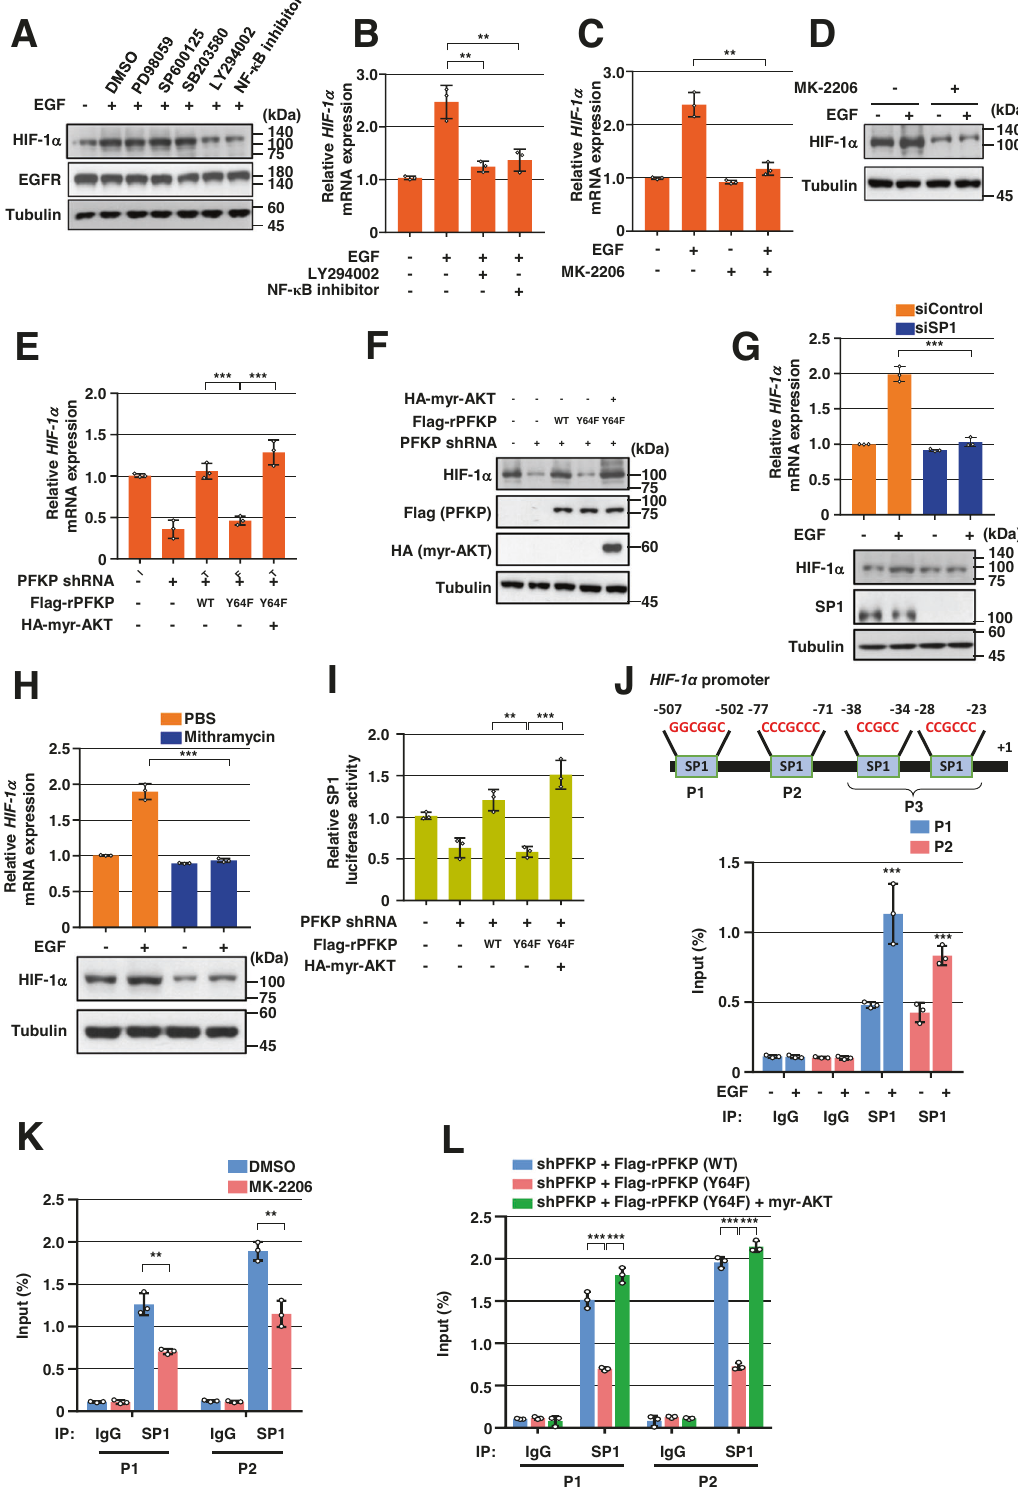
expressing its WT counterpart, however, this reduction was abrogated by expressing an active AKT1 mutant (Fig. 2I). Next, we performed a chromatin immune precipitation (ChIP) assay with an anti-SP1 antibody to identify the exact binding site of SP1 in the promoter region of the HIF-1 α gene in response to